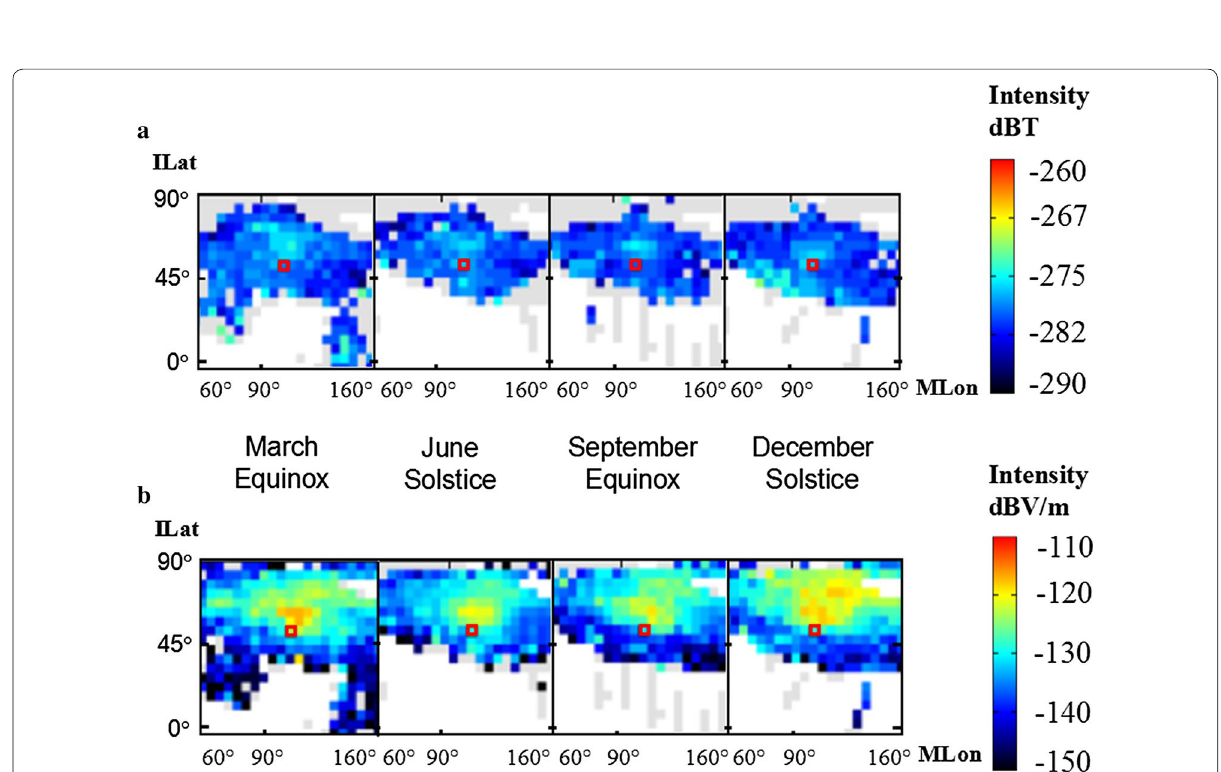
Fig. 8 a Seasonal propagation of the Omega signal from the Norway station in the magnetic field and b in the electric field based on invariant